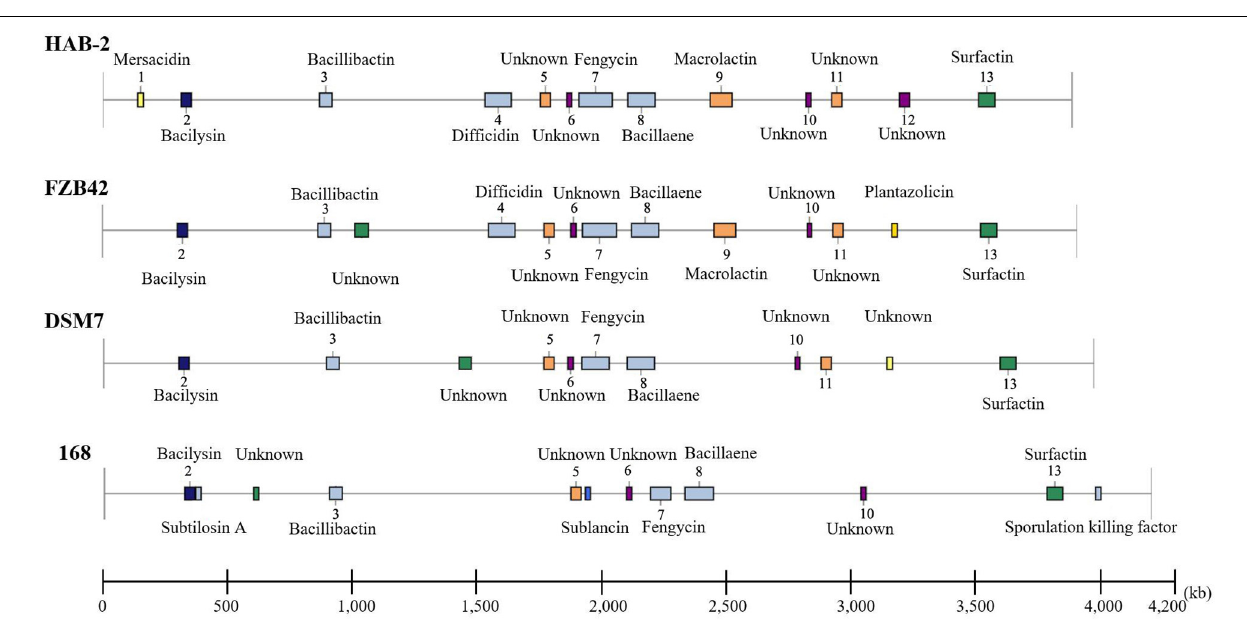
FIGURE 7 | Comparative analysis of the location and products of secondary metabolite gene clusters in B. velezensis HAB-2, B. velezensis FZB42, B. amyloliquefaciens DSM7 and B. subtilis